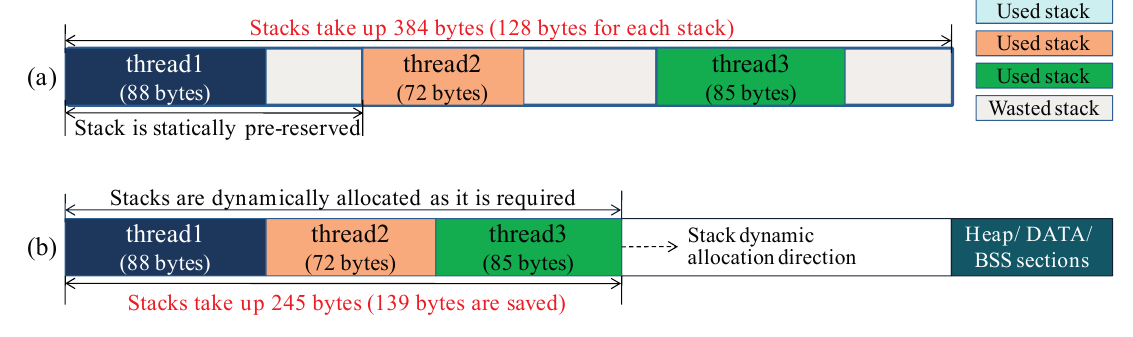
Figure 5. ( a ) In traditional multithreaded OS, stacks are statically pre-reserved, and the stack size is assigned heuristically. Memory waste should exist in this case; ( b ) In LiveOS, stacks are allocated dynamically within a shared stack. By doing this, memory waste can be avoided. In this example, 139-byte memory is saved by